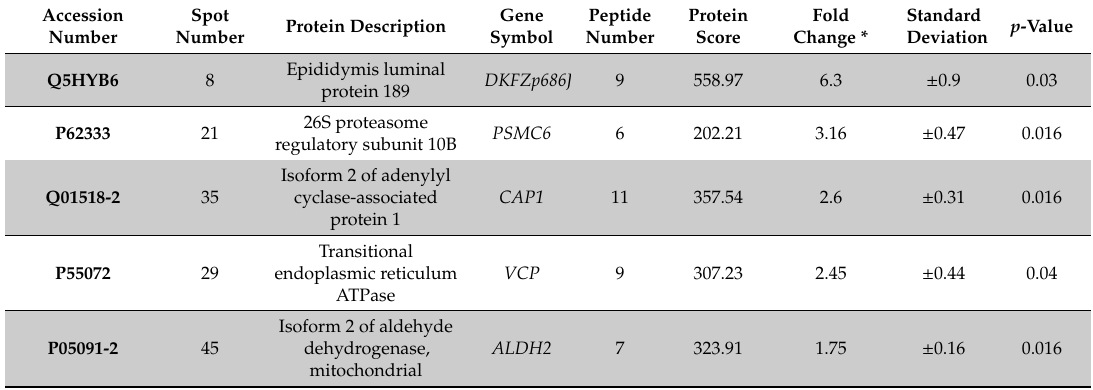
Figure 1. Two dimensional electrophoresis map of the adenotonsillar hypertrophy (ATH) and recurrent acute otitis media (RAOM) proteome. Immobilized pH gradient pH 3–10 non-linear strips were used for the first dimension and 12% polyacrylamide gels were used for the second dimension. Number correspond to di ff erent proteins identified in Table 1. Table 1. Dysregulated proteins identified by mass spectrometry in RAOM compared to ATH.